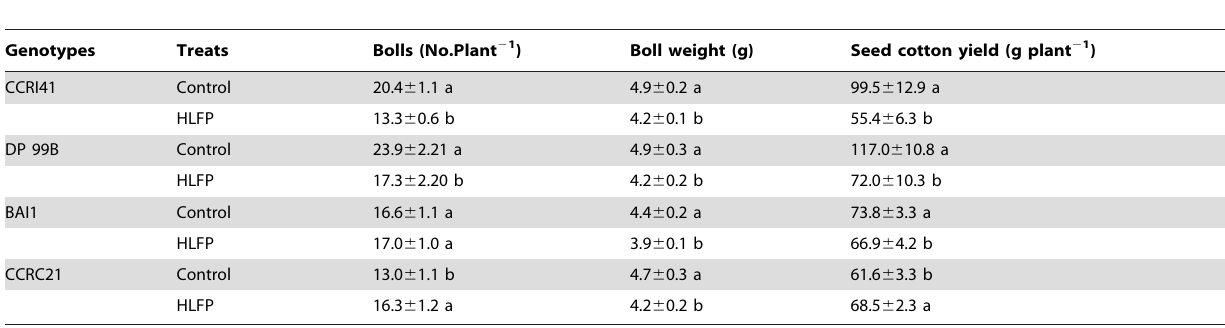
Table 4. Effects of mechanical stress caused by hanging labels from the petioles (HLFP) of every white flower in the field on the number of bolls, boll weight and seed cotton yield for four cotton